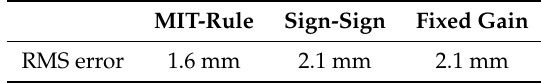
Table 3. Comparison of RMS position error after convergence in simulation.